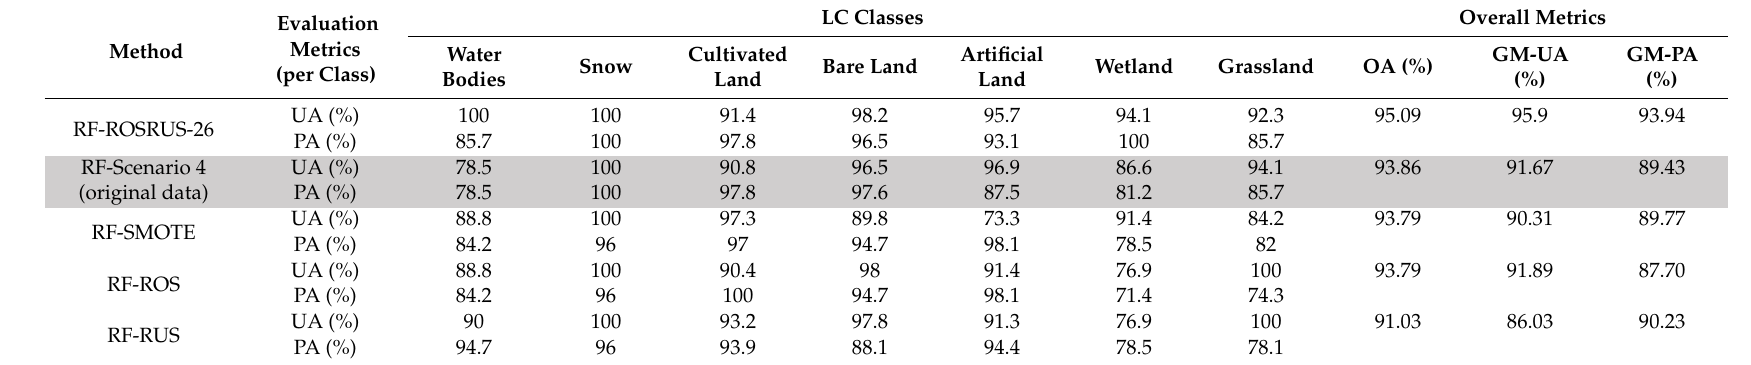
Table A5. Accuracy assessment of the four data balancing methods and traditional RF (Scenario-4) over